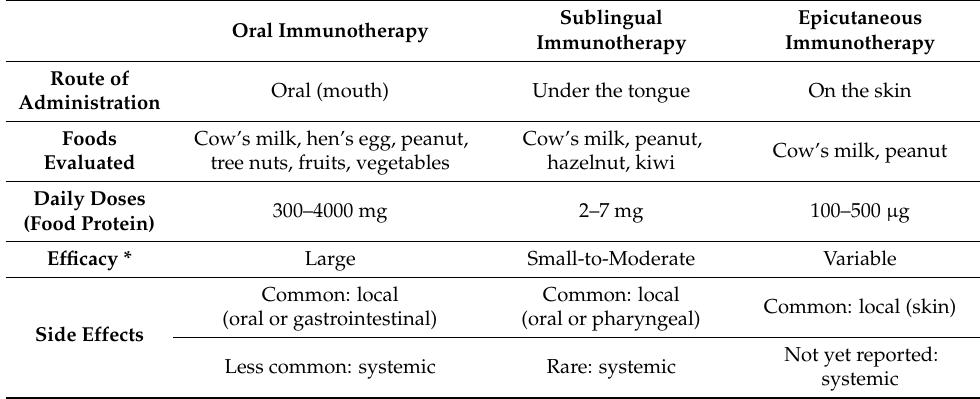
Table 1. Outline of the different forms of food